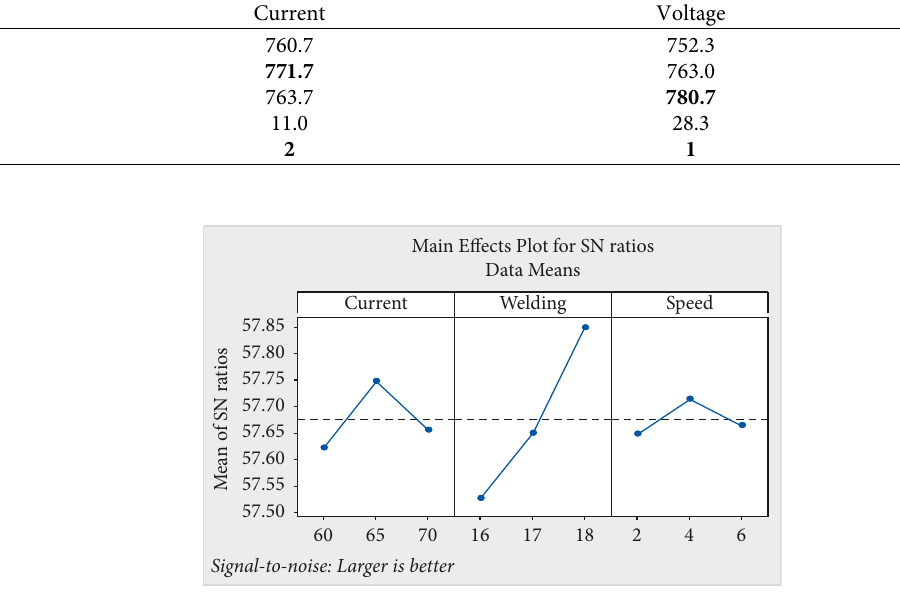
Figure 10: Main effects plot for S/N of tensile